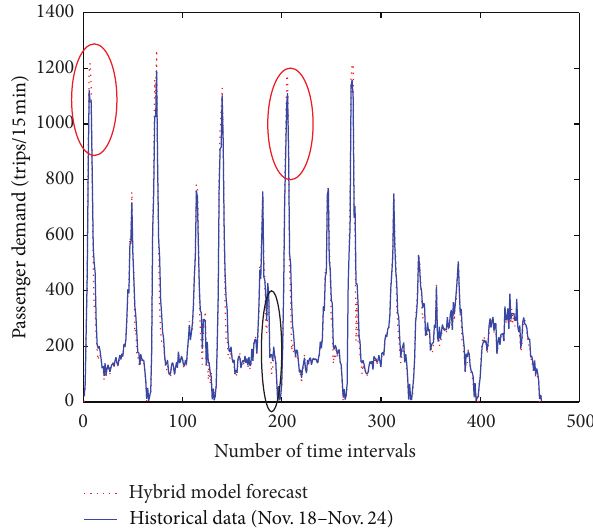
Figure 3: IMM forecast results for the source sample from Novem- ber 18 to November 24,